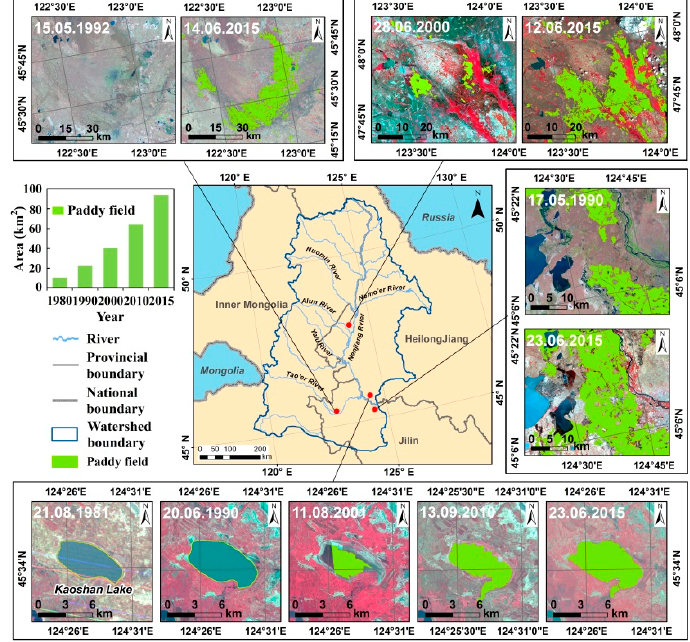
Figure 11. Image examples for lakes and reservoirs affected by the expanded paddy fields.